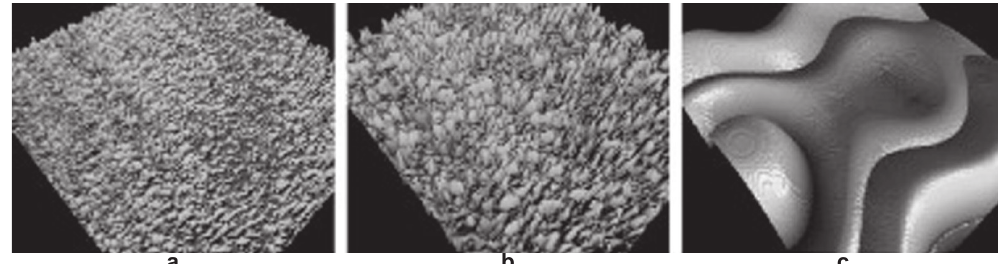
Figure 2- a, b and c: Filter sequence in which the undulations and shapes have been